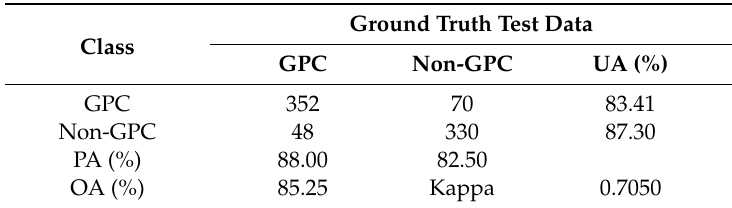
Table 3. Confusion matrix based on the initial training set.